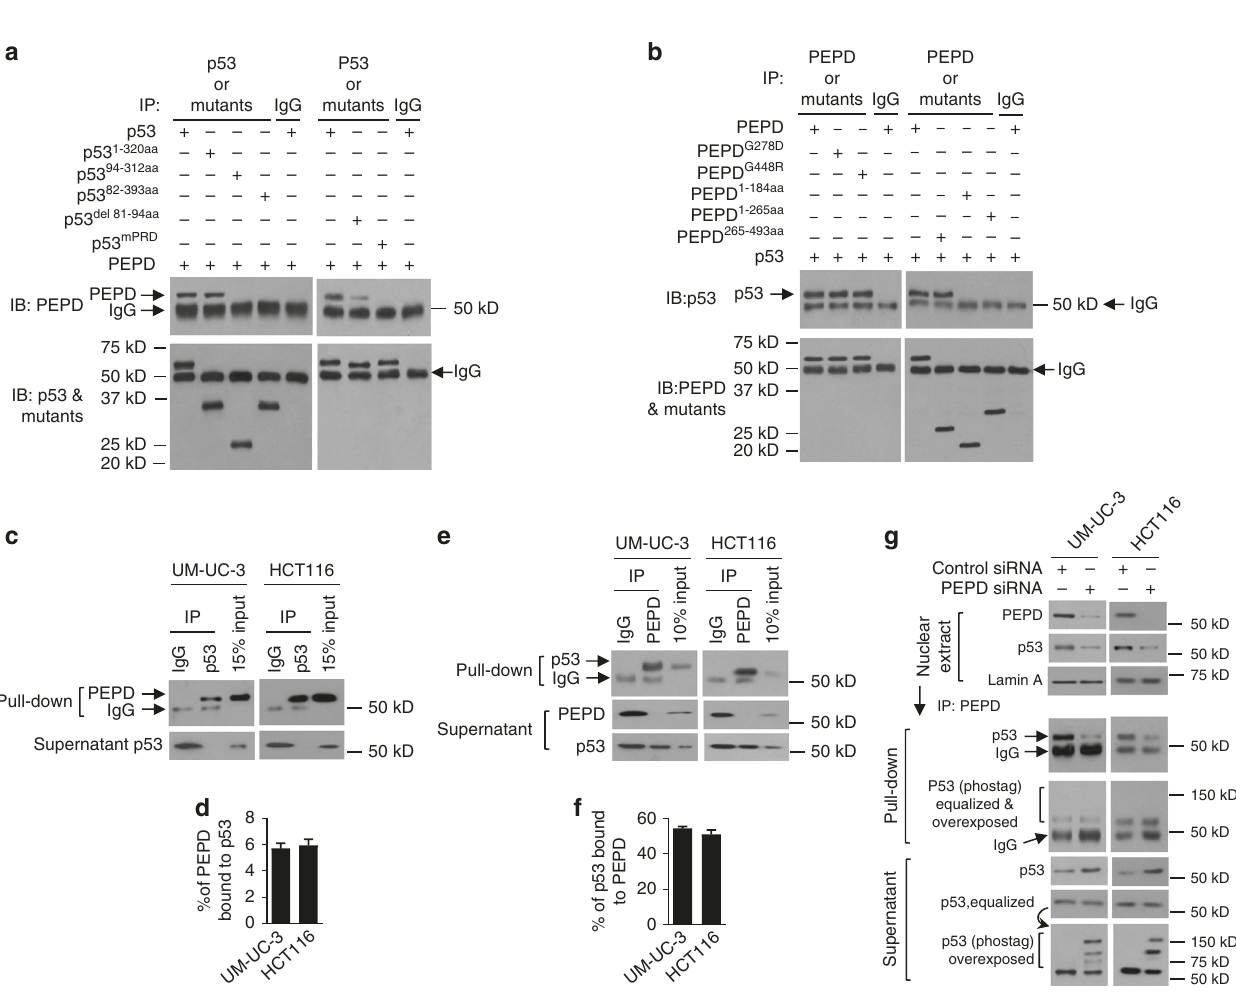
Fig. 5 PEPD binds to PRD in p53 and blocks nuclear p53 activation. a IP-IB analysis of direct binding of p53 and its mutants to PEPD. b IP-IB analysis of direct binding of PEPD and its mutants to p53. c – f IP-IB analysis of percentages of cellular p53 that binds to PEPD and cellular PEPD that binds to p53. IB bands were quanti fi ed by ImageJ. Error bars are mean ± SD ( n = 3). g IB analysis of PEPD and p53 and IP-IB analyses of PEPD-free p53 and phosphor-p53 in nuclear fraction of cells treated with siRNA for 72 h. Lamin A was measured as a loading control. Cells were cultured in 6-well plates (5 – 10 × 10 4 cells/ well) for 24 h before siRNA